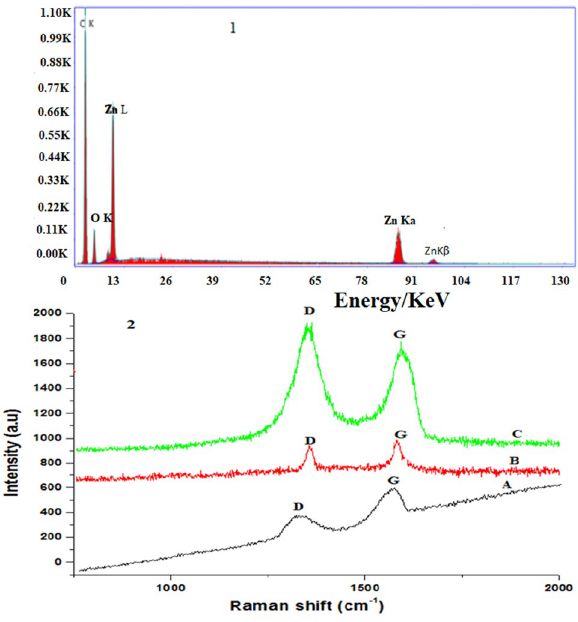
Figure 5. (1) Energy dispersive x-ray spectra of GN:ZnO NC. (2) Raman-spectra of ( A ) GO, ( B ) GN and ( C ) GN:ZnO